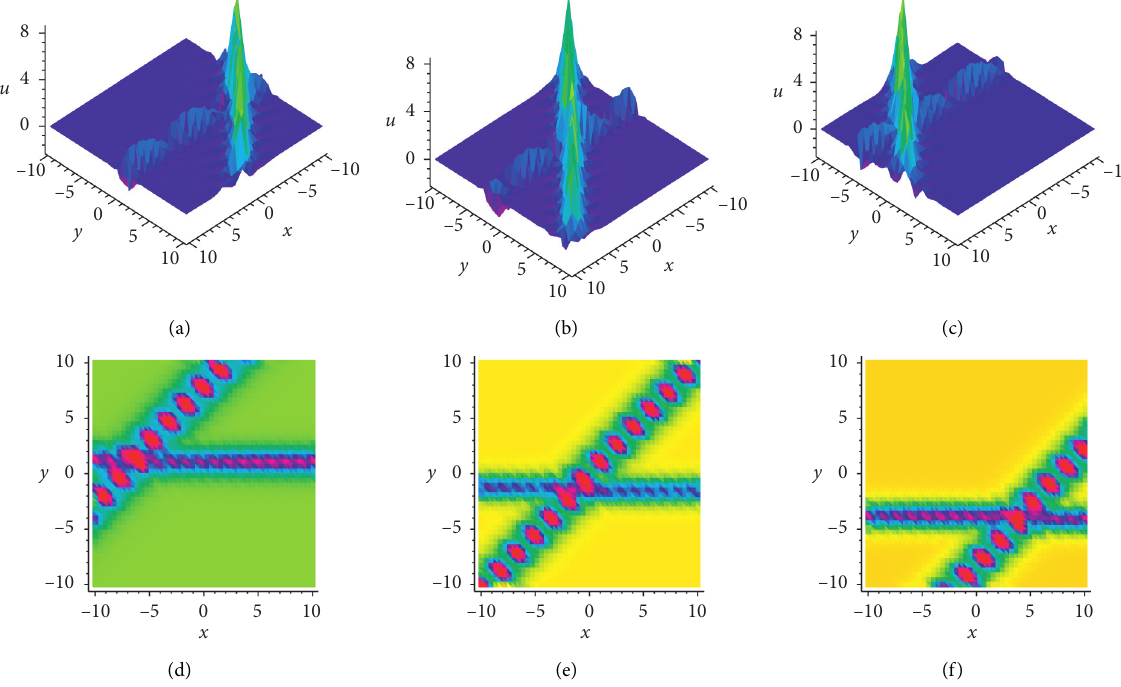
Figure 3: Evolution graphs of the second-order breather solution: (a), (b), and (c) are the three-dimensional plots at t � − 3, t � 0, and t � 3, and (d), (e), and (f) are the corresponding density plots at t � − 3, t � 0, and t �